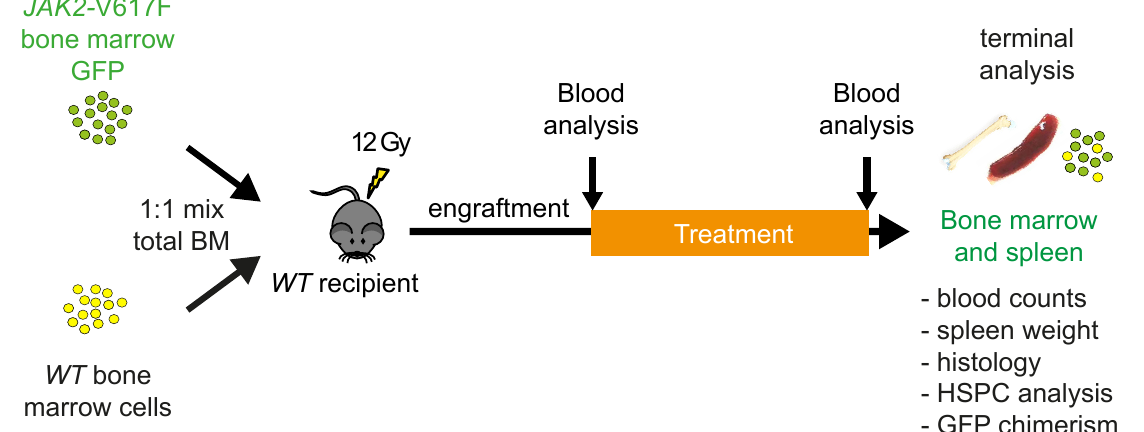
Fig. 3. Experimental setup for candidate drug testing in pre-clinical MPN mouse models with GFP reporter gene. Bone marrow (BM) cells co-expressing JAK2 -V617F + and GFP in all hematopoietic cells (green) are mixed with wildtype ( WT) competitor cells (yellow) and injected into lethally irradiated syngeneic recipient mice. After engraftment, the recipient mice are allowed to develop MPN phenotype and are randomized into treatment or vehicle control groups. Complete blood counts and GFP chimerism are determined in peripheral blood at defined timepoints. At the end of the treatment the mice are sacrificed, and terminal analysis of cells and organs is